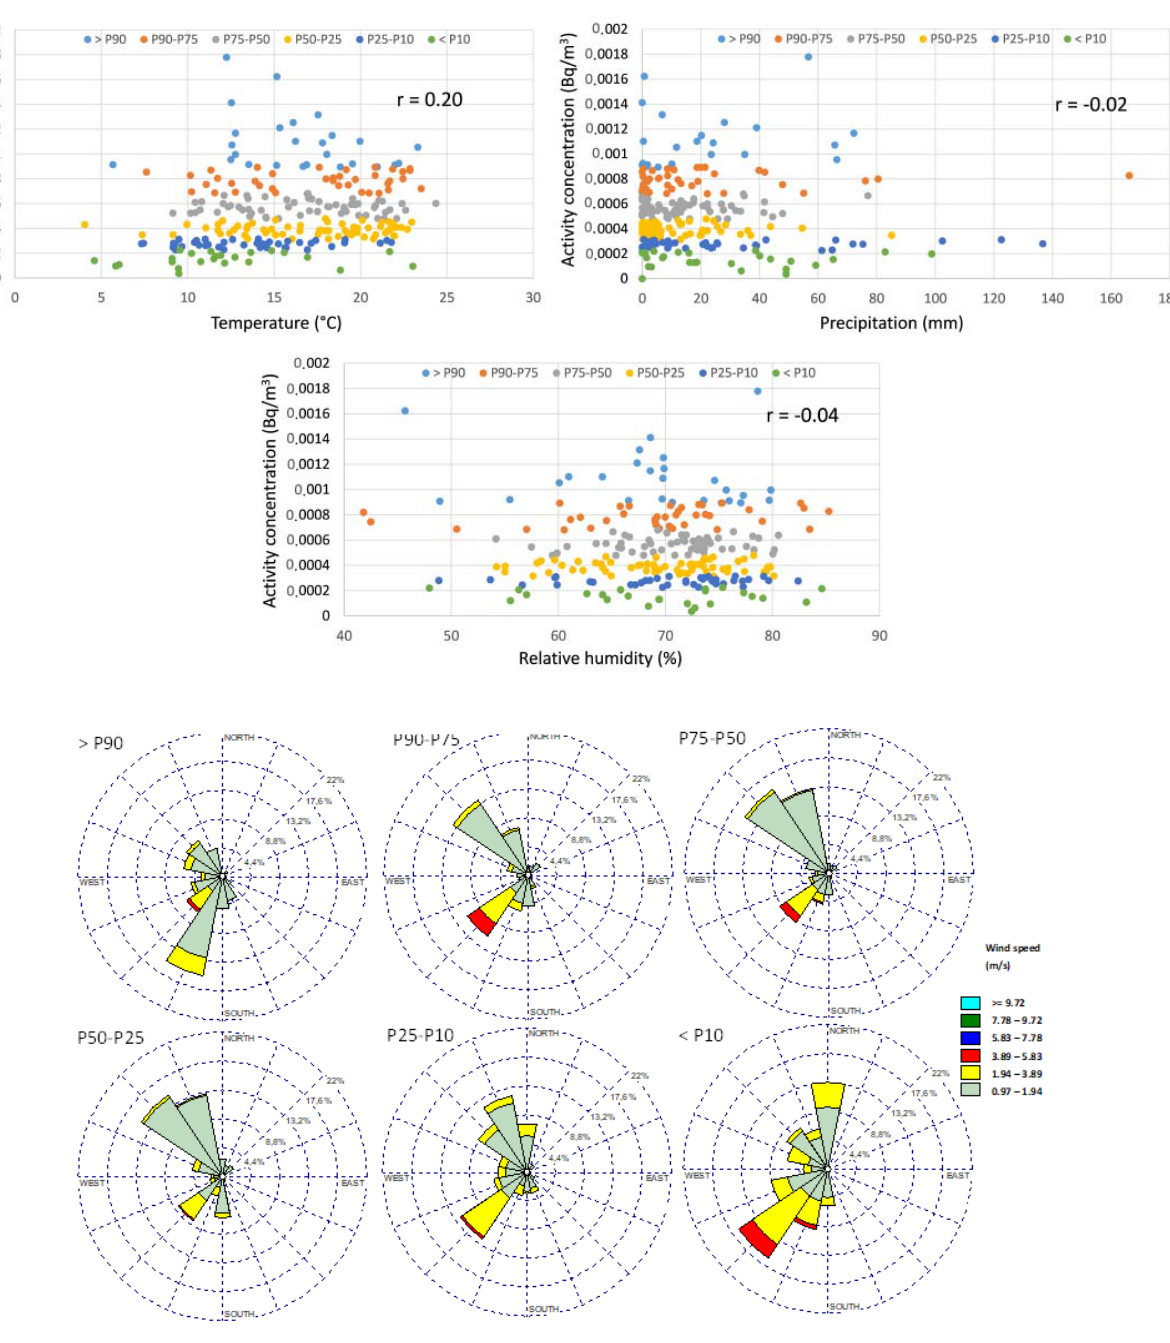
Figure 8. Relationship between temperature, precipitation, relative humidity, wind speed and direction, and beta activity concentrations in Bilbao.